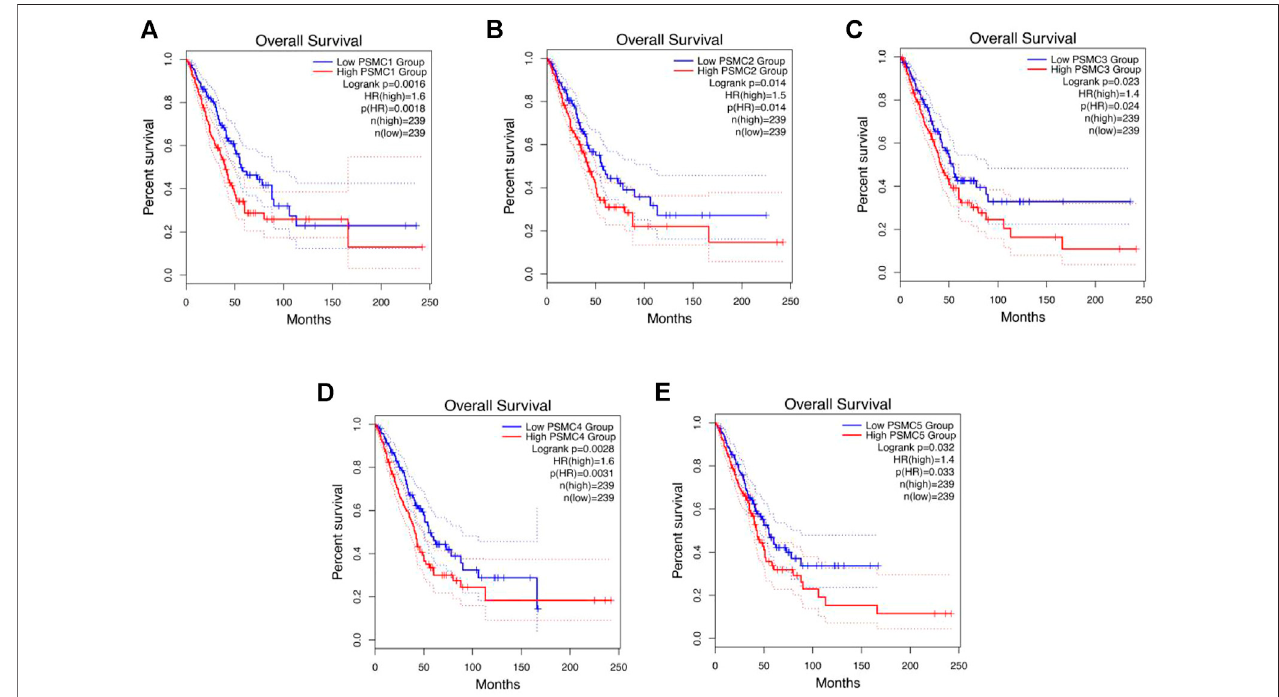
FIGURE 7 | Kaplan – Meier plot representation of PSMC1 (A) , PSMC2 (B) , PSMC3 (C) , PSMC4 (D) , and PSMC5 (E) expressions and their relation with the OS of LUADpatients.Theredcolorplotrepresentsthehigh PSMC -expressingLUADpatients,andthebluecolorplotrepresentsthelow PSMC -expressinggroup.Thevertical tick mark within the plot indicates an event (death). A signi fi cant negative association was observed between PSMC s expression and LUAD patients ’ OS ( p < 0.05, HR: < 1.4).